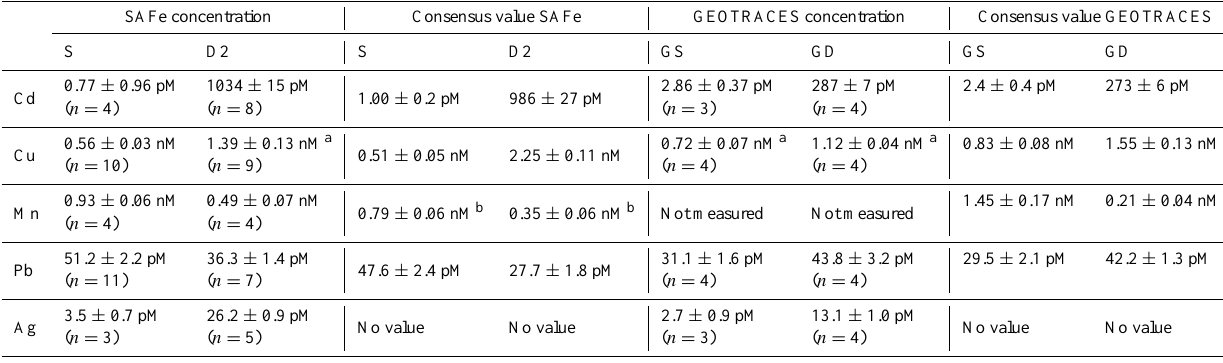
Table 1. Comparison of dissolved Cd, Cu, Pb and Ag analyses obtained in the present study by the ID-ICPMS method and of dissolved Mn obtained by the internal standard addition and ICPMS detection, with the consensus values reported by the SAFe project (in the surface-S and deep-D2 samples) and in the North Atlantic GEOTRACES (in the surface-GS and deep-GD samples) Reference Samples (updated in November 2011). All ± terms represent standard deviation from average